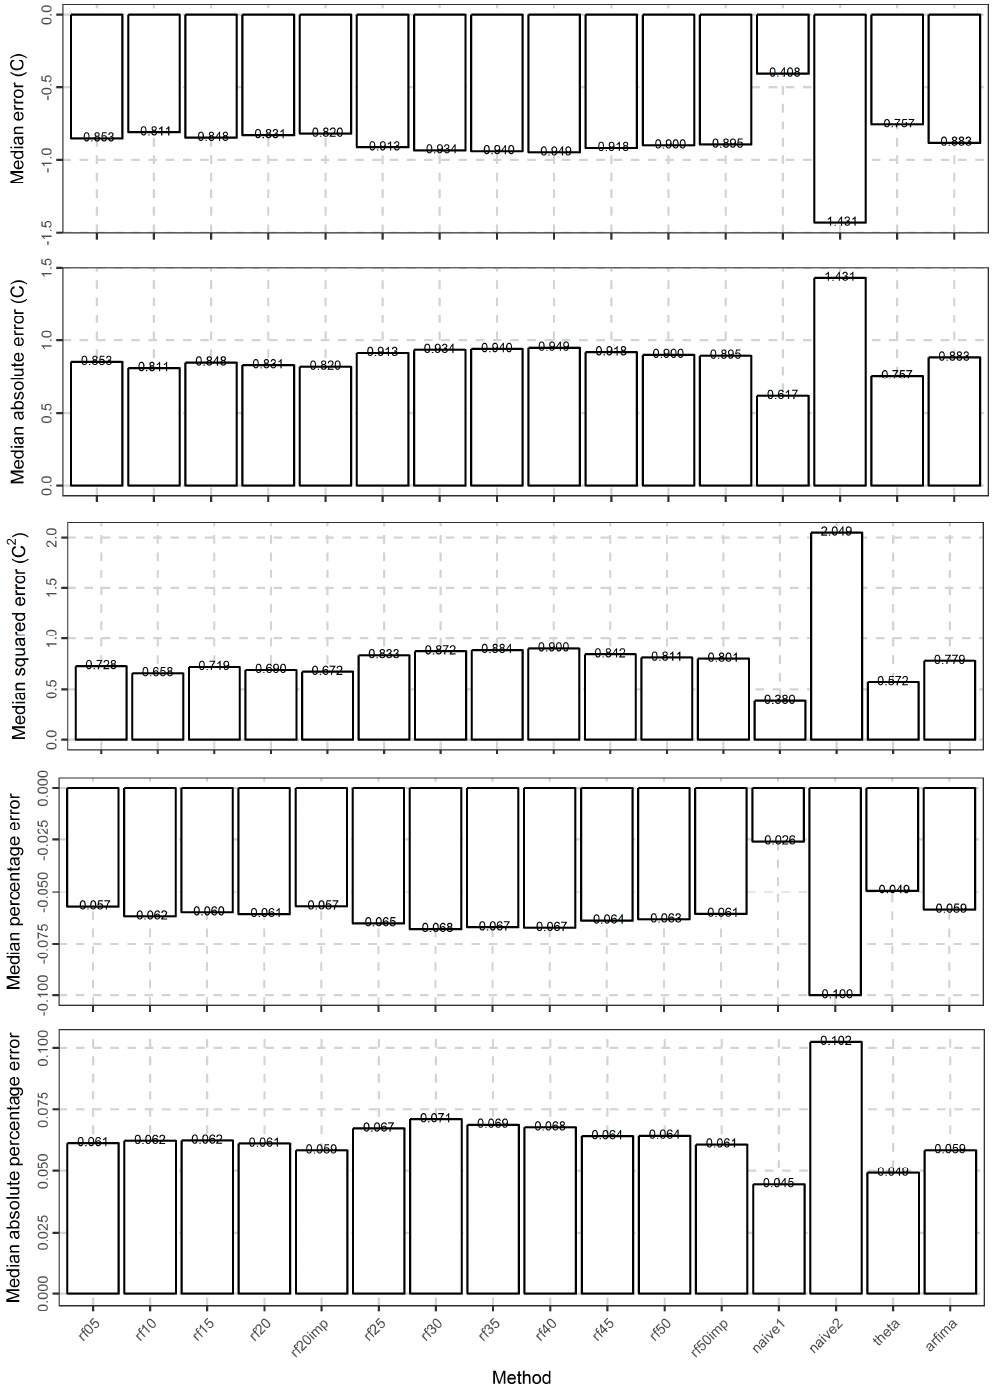
Figure 15. Barplots of the medians of various types of metrics measuring the error of the temperature forecasts for all the methods. The types of errors are depicted in the vertical axes. Regarding the rf methods, the best performance is exhibited by the rf10 method in terms of the median of errors, median of absolute error, and median of squared errors. On the contrary, with respect to the median of percentage errors and the median of absolute percentage errors the best rf method is rf20imp. In general, the performance of the rf05, rf10, rf15, rf20, rf20imp methods are close in terms of the median values of the metrics. The same applies to the performance of all the remaining rf methods, which nevertheless are worse. The arfima method has a similar performance with the worst rf methods. In Figure 16, we present the regression coefficients between the forecasted and the test values. Here the differences between the methods are negligible. The best method is theta, followed by the rf05 and arfima methods. Moreover, the regression coefficient increases with the increase of the number of predictor variables. Additionally, using the important variables results in better results, e.g., rf20imp is better than rf20.